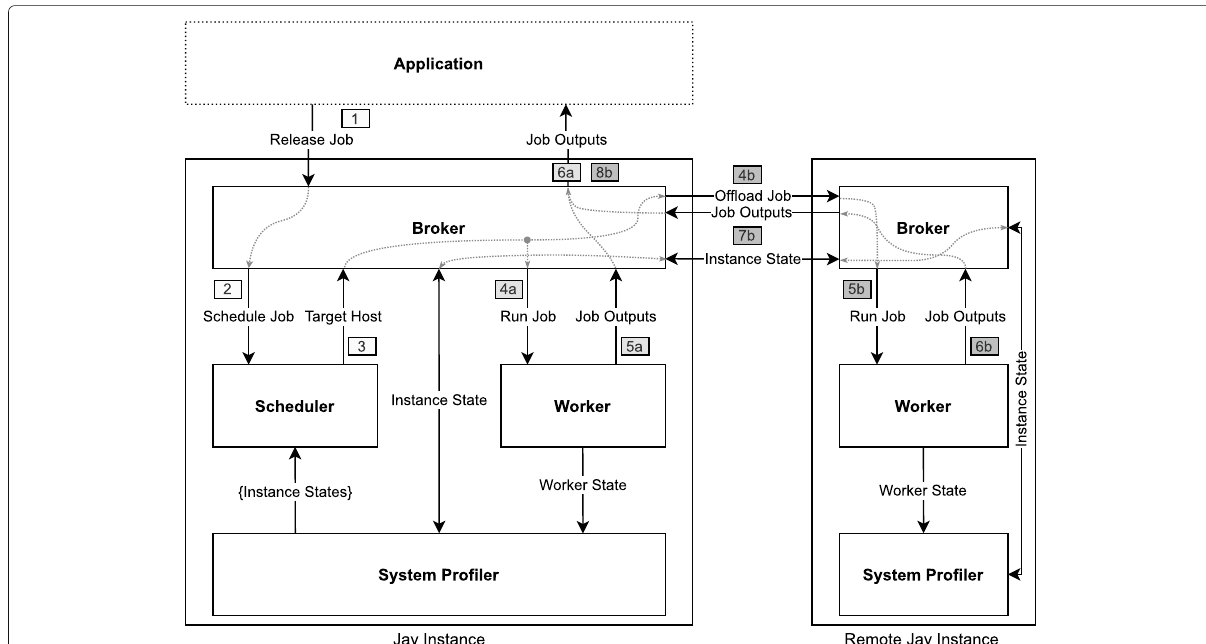
Fig. 4 Life cycle of a job in J